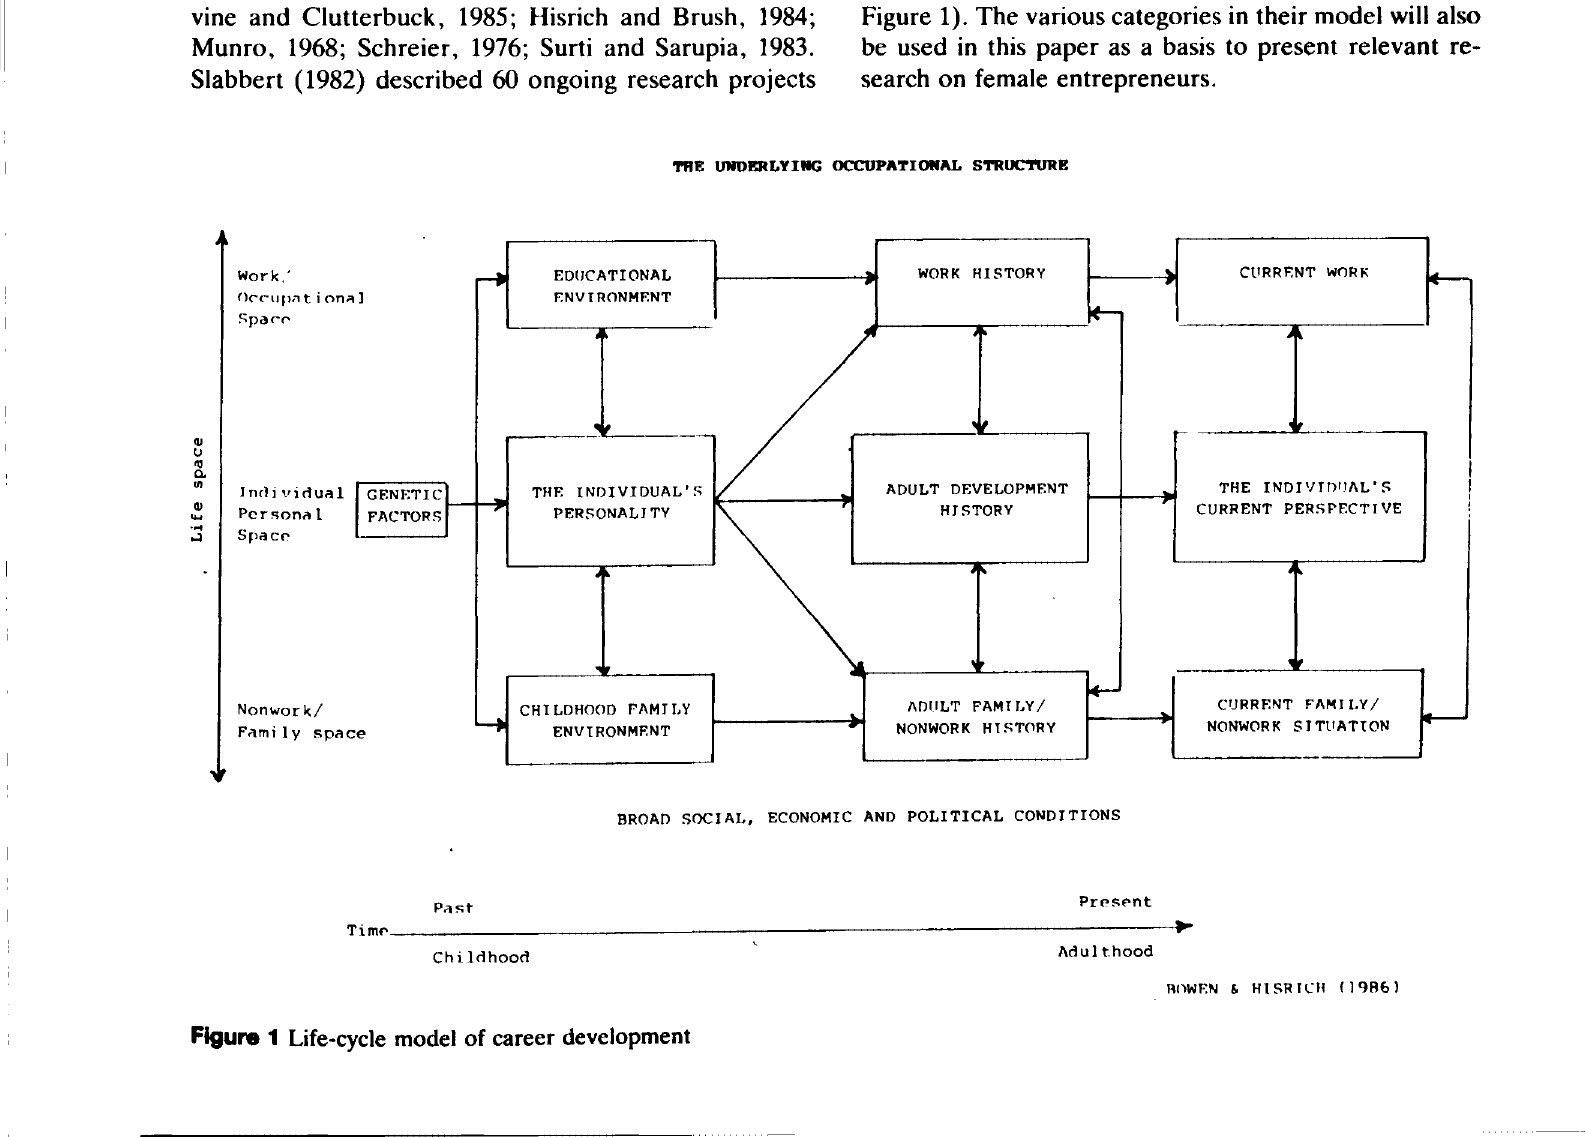
Figure 1 Life-cycle model of career